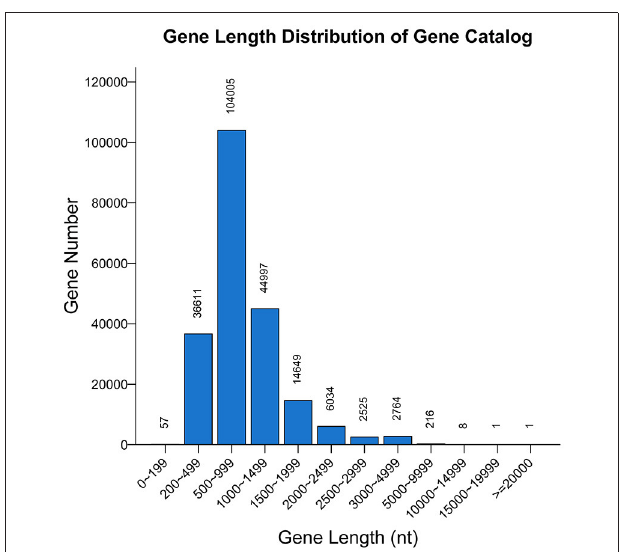
FIGURE 1 | Length distribution of genes. The X-axis indicates the length intervals, and the Y-axis represents the number of